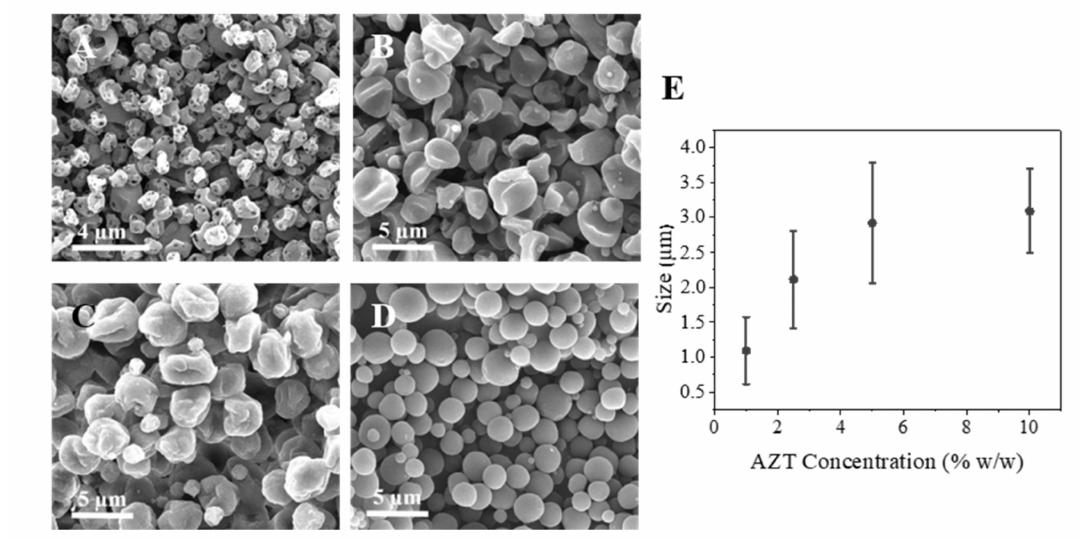
Figure 2. Particle size according to the concentration (% w / w ) and the flow used (1.5 mL/h) with chloroform as solvent: ( A ) 1% w / w ; ( B ) 2.5% w / w ; ( C ) 5% w / w ; ( D ) 10% w / w ; ( E ) Influence of azithromycin concentration on particle size distribution (mean ± SD, n = 3).